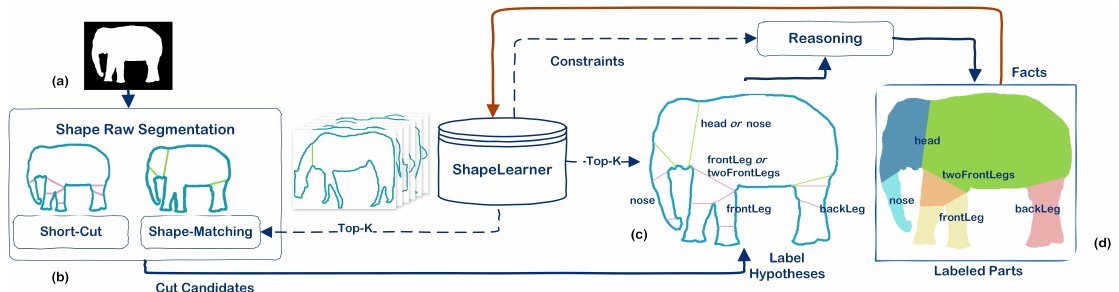
Figure 2: Workflow diagram. Given an unknown 2D shape (a), ShapeLearner first determines segmentation candidates by leveraging short cut and shape matching information (b). The system uses its acquired knowledge to label candidates (c). Finally, it makes use of